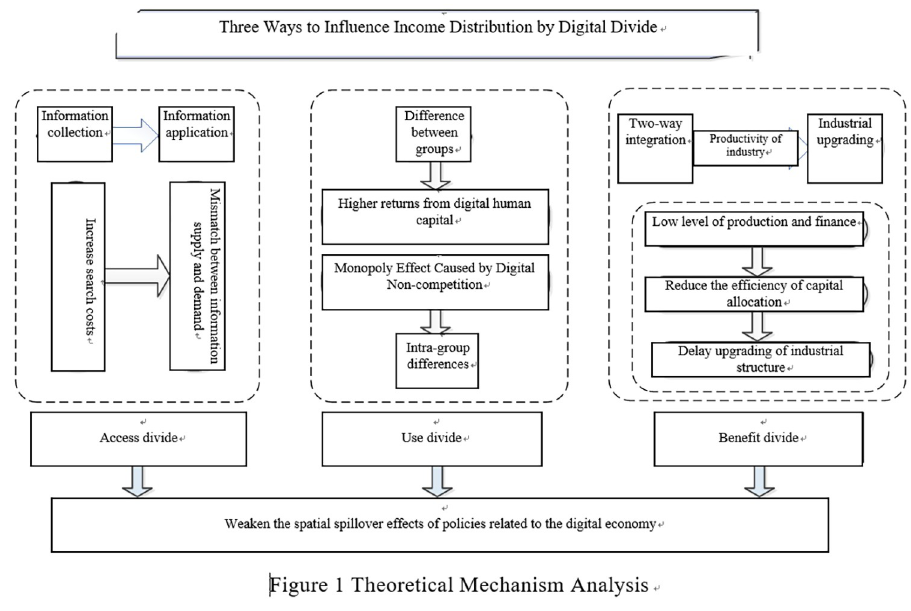
Fig 1. Flowchart on theoretical mechanisms. Source: Drawn by